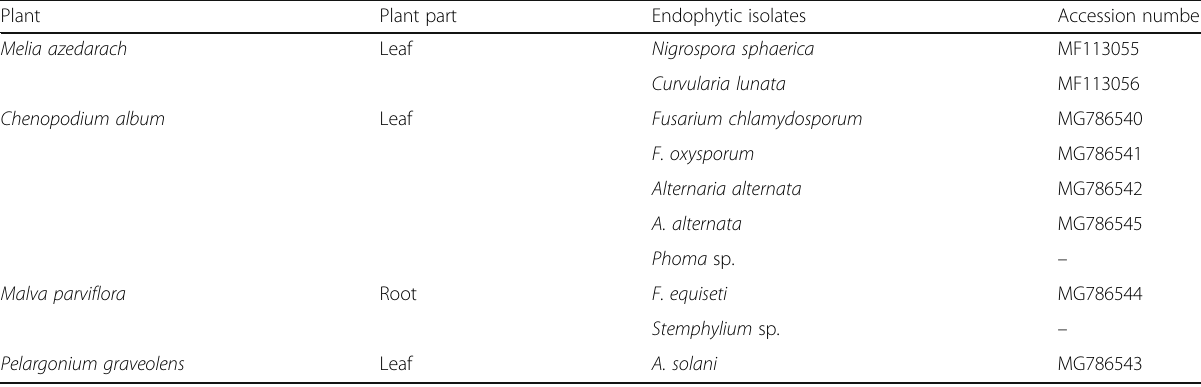
Table 1 Endophytic fungi isolated from plant leaves and roots and their accession numbers Plant Plant part